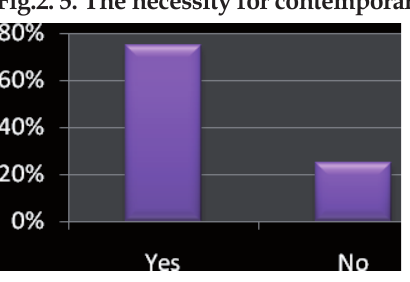
Fig.2. 5. The necessity for contemporary educational models.